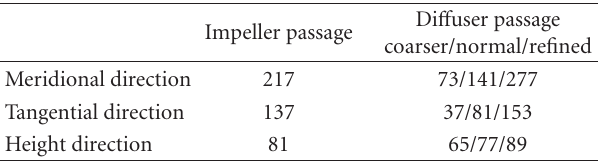
Table 1: Main mesh dimensions without upstream and down- stream H-blocks.